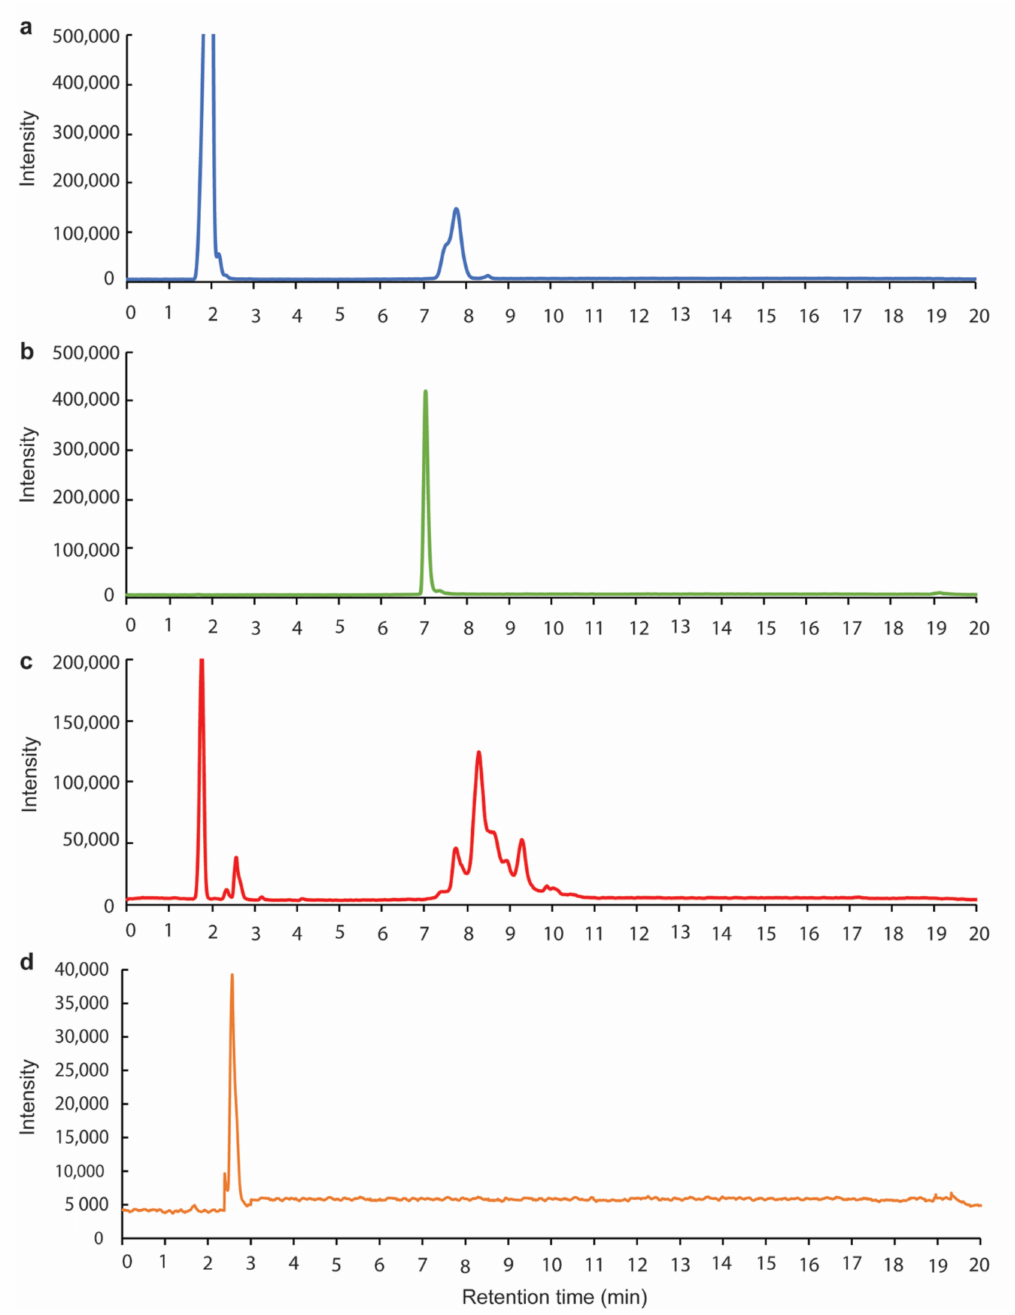
Figure 2. HPLC chromatograms of ( a ) NHS-PEG-COOH linker, ( b ) CSA-90, ( c ) synthesized and purified BBA-1 and ( d ) 1-ethyl-3-(3-dimethylaminopropyl) carbodiimide hydrochloride